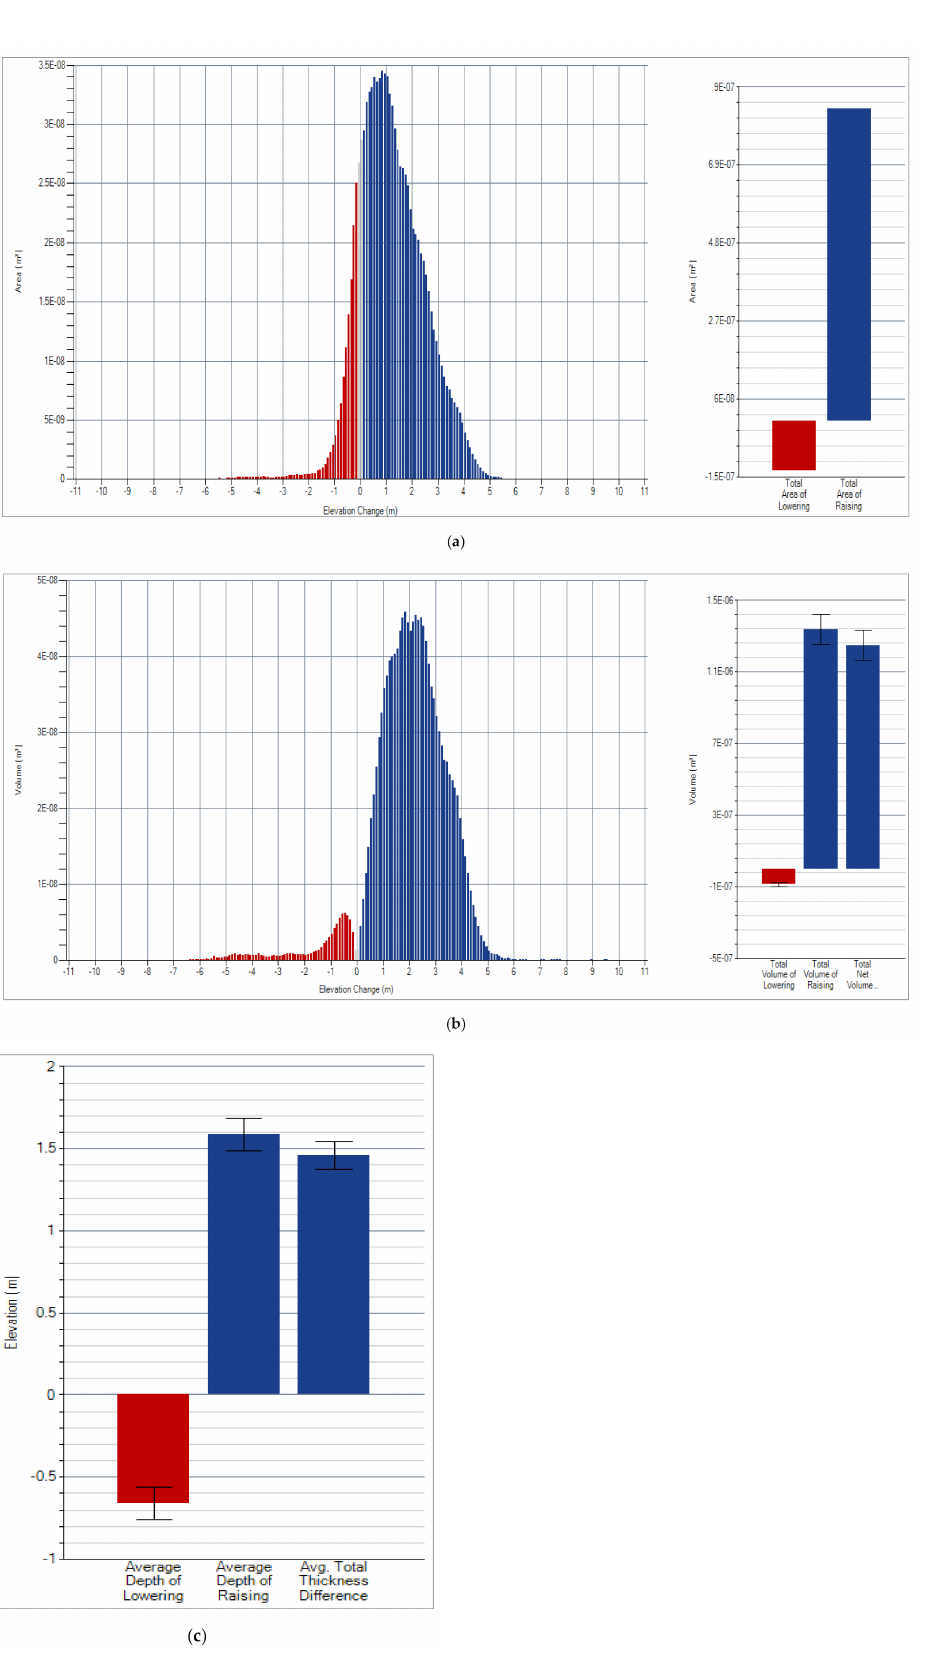
Figure A5. GCD result for ROI